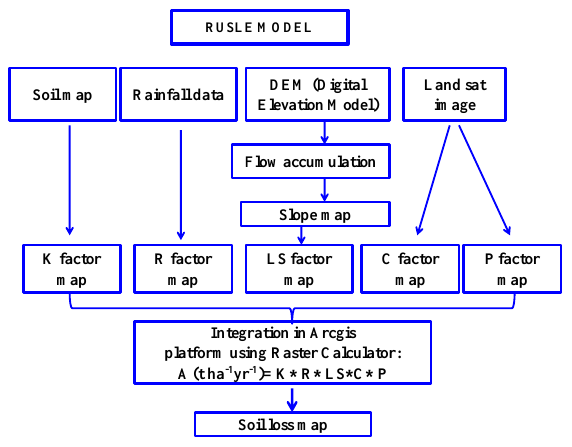
Figure 2. Diagram of the Soil loss analysis by RUSLE model